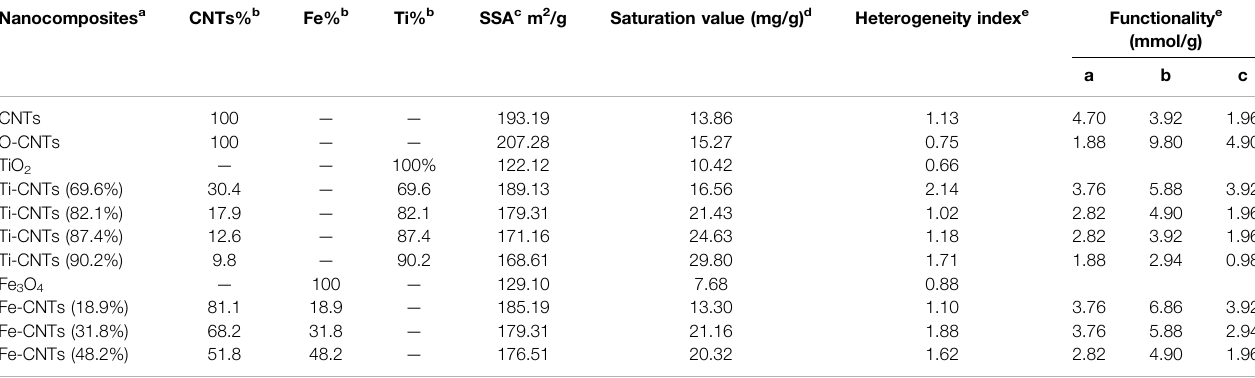
a Values between brackets indicated the ratios the nano-materials in the fi nal mix. b Percentages were calculated based on limiting reactant of the reagents involved in synthesis of Fe 3 O 4 and TiO 2 .